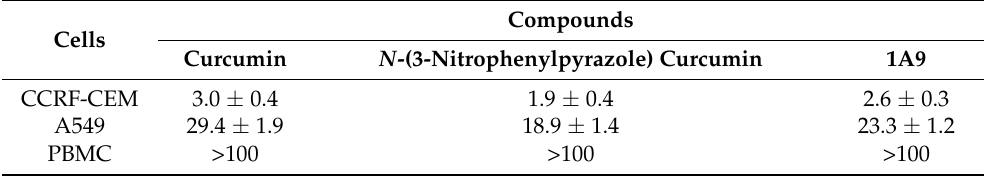
Table 2. IC 50 values of CCRF-CEM leukemia and A549 lung carcinoma cells treated with